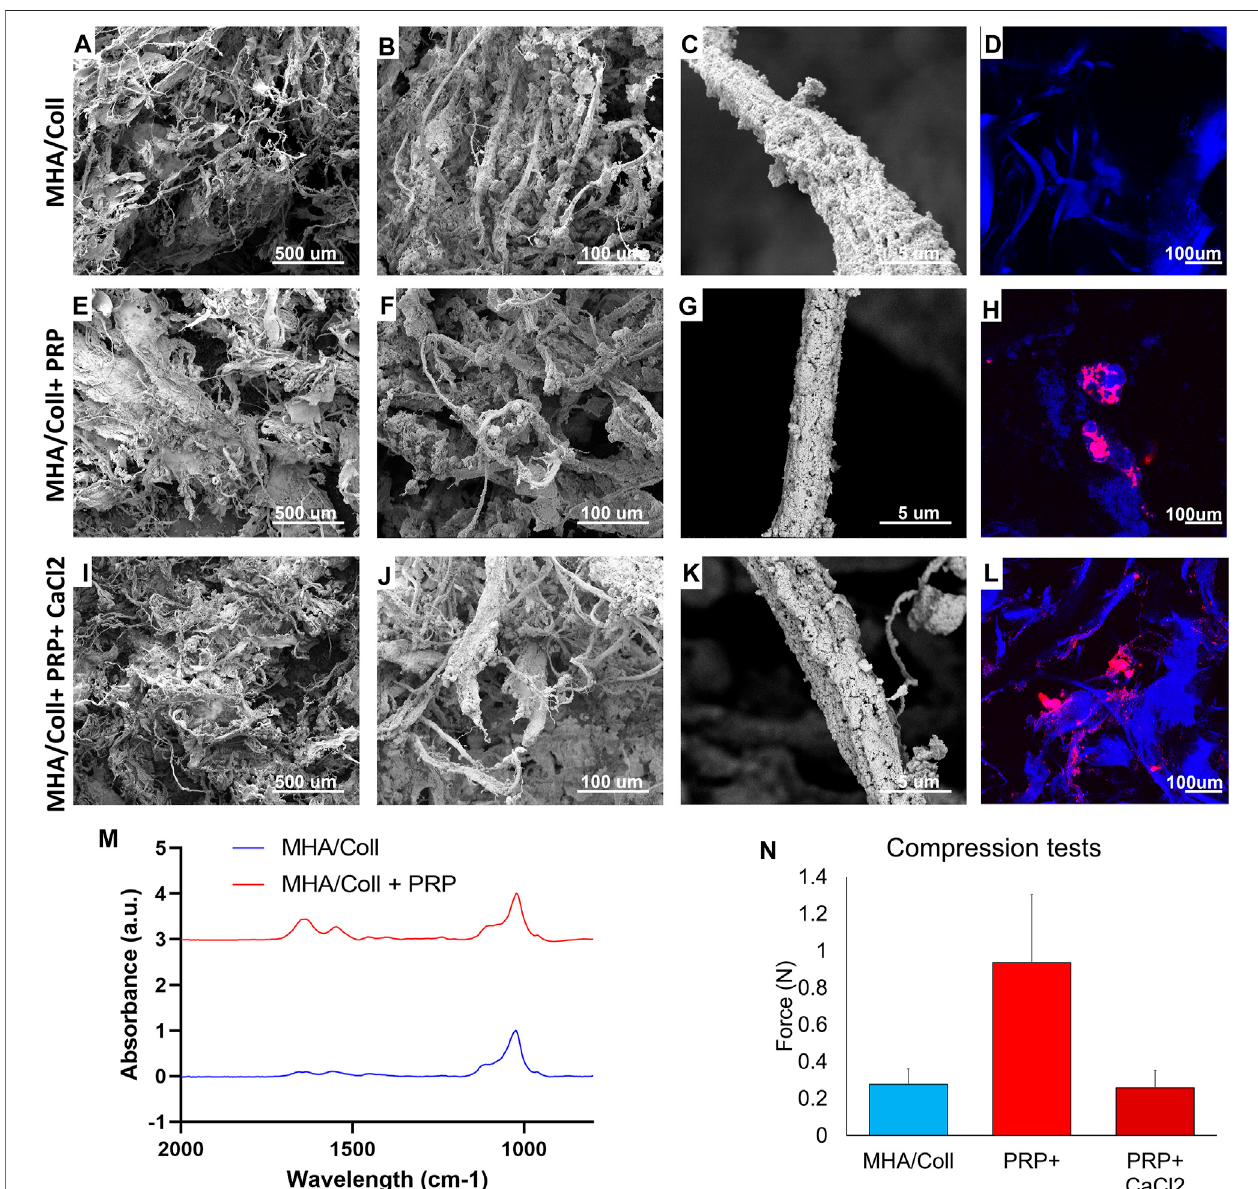
FIGURE3| MaterialCharacterization.SEMwasusedtocharacterizesurfacetopography,poresize,anduniformityofourMHA/Collscaffoldalone (A – C) ,MHA/Coll + PRP (E – G) , and MHA/Coll + PRP + CaCl2 (I – K) . Confocal microscopy was used in a DAPI channel to characterize collagen fi bril auto fl uorescence including on MHA/ Coll scaffolds alone (D) , and distribution of labeled PRP alone (H) or after CaCl2 activation (L) . FTIR analysis was used to assess differences in spectra from MHA/Coll scaffolds alone or with the addition of PRP (M) . Changes in compression/stretch were also characterized (N) .